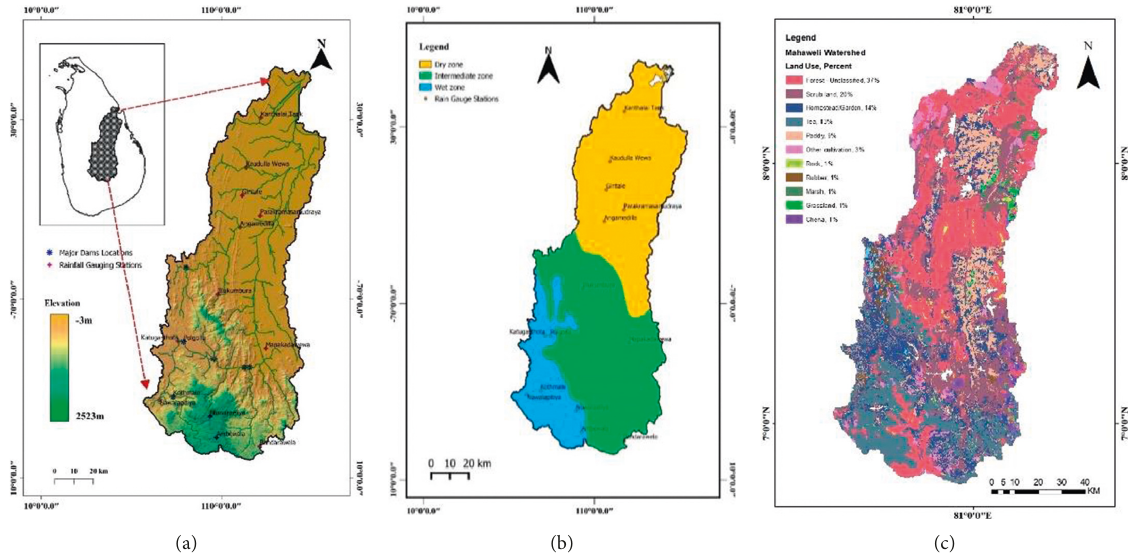
Figure 1: Maps of MRB, Sri Lanka. (a) The Mahaweli River Basin, Sri Lanka. (b) Climate zones of the MRB. (c) Land use map of the